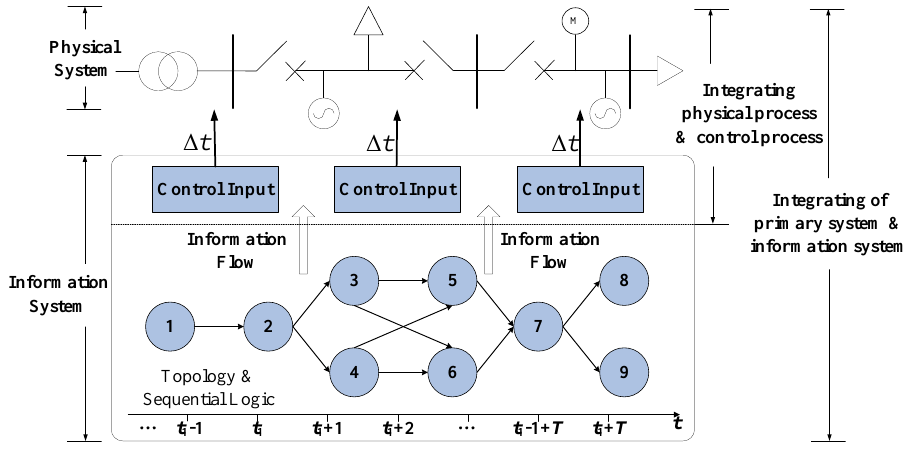
Figure 2. Relationship between two “Integration” of “Control Model”.